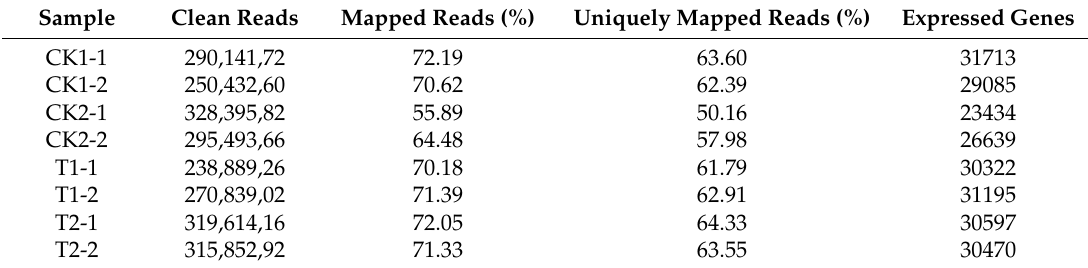
Table 1. Throughput and quality of RNA-seq of differentially expressed genes (DGEs) libraries from “Granny Smith” apple skins.